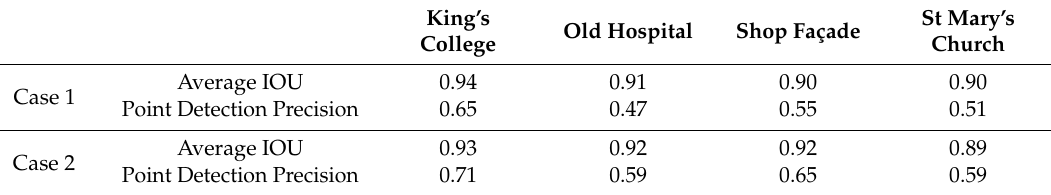
Table 2. Comparison of point detection performance by scene and experimental configuration.